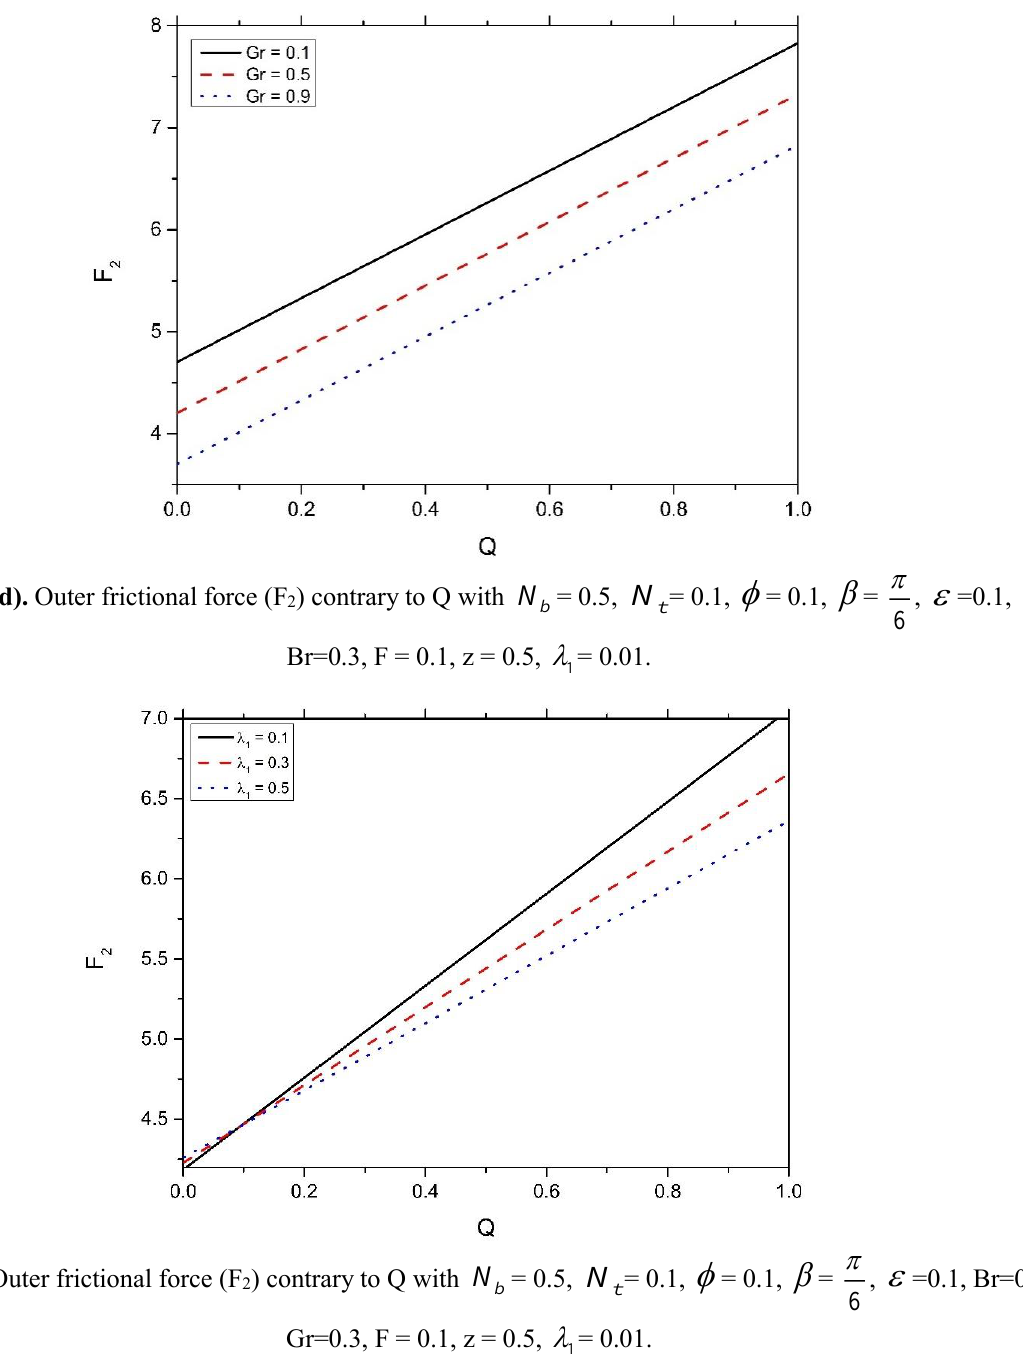
Gr=0.3, F = 0.1, z = 0.5,